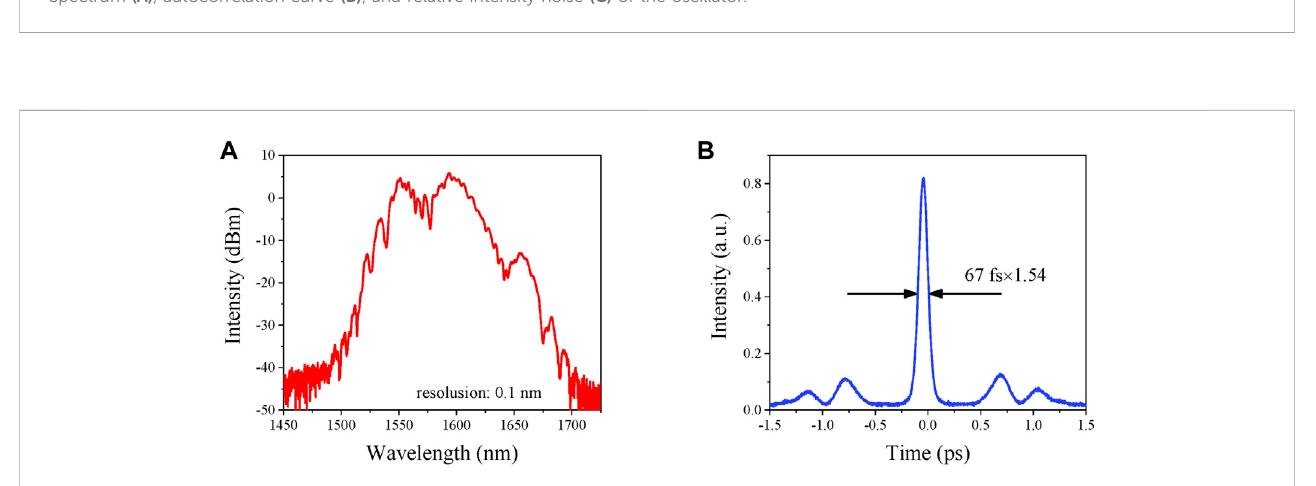
FIGURE 3 (A) Spectrum and (B) autocorrelation curve of the